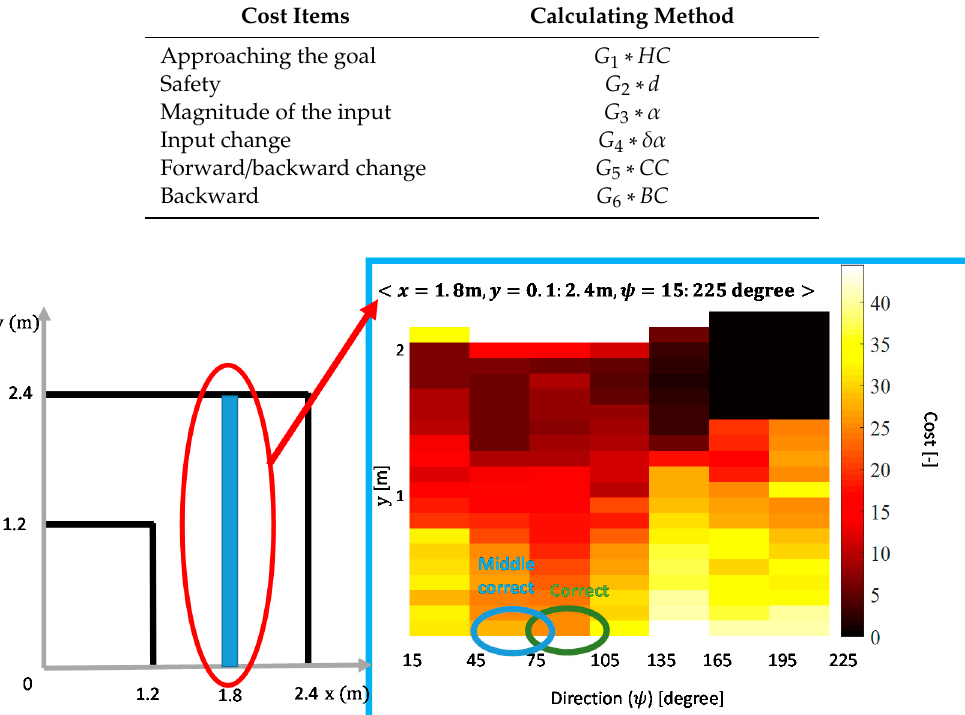
Figure 10. Example of cost determination using Hybrid A* (HA*) < x = 2 m, y = 0.1:2.4 m, ψ = 15: 225 ∘ >. Table 2. Items for the cost function in HA* to calculate the predicted reward. Cost Items